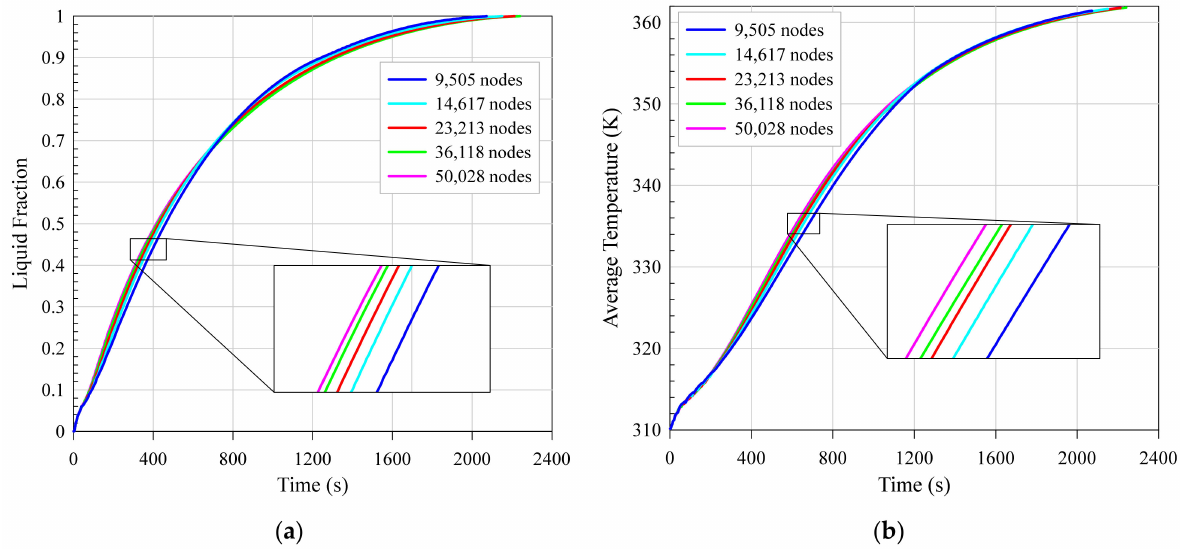
Figure 3. Grid independency study for ( a ) transient liquid fraction, and ( b ) transient average